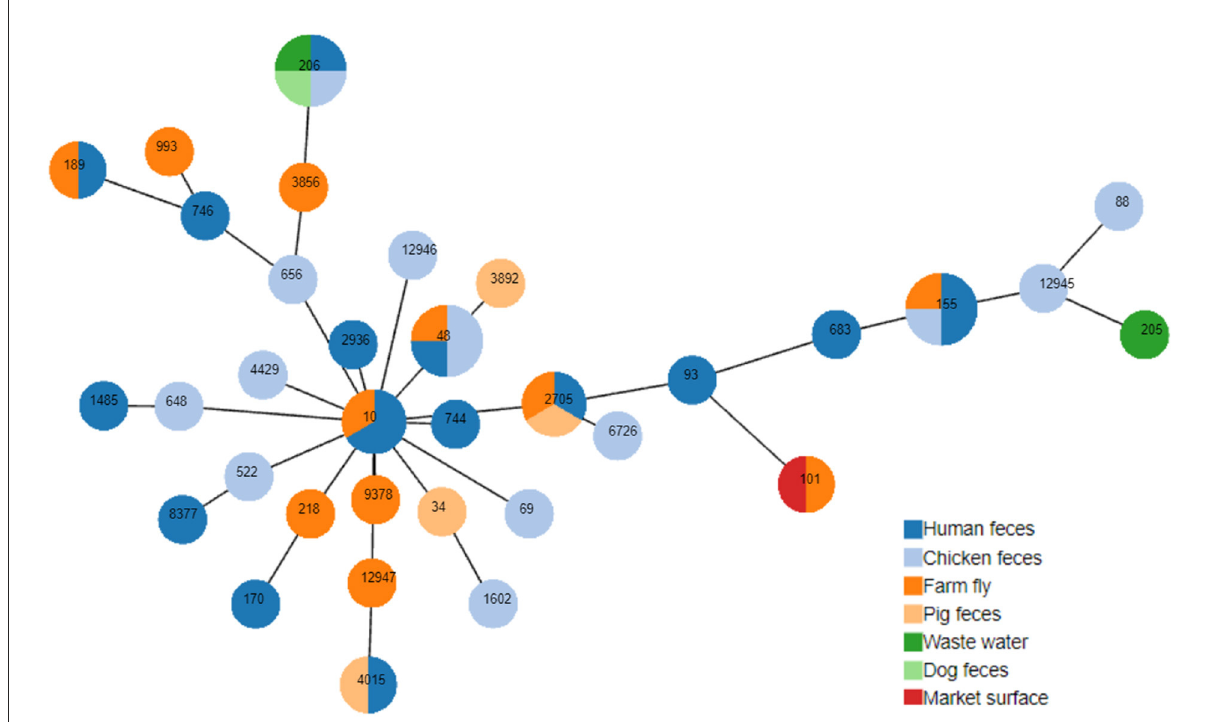
FIGURE1 Minimum spanning tree based on multi-locus sequence types and seven housekeeping gene alleles of MCRPEC. Each circle corresponds to an individual sequence type (ST), the circle size indicated the number of isolates assigned to the same ST; The color of the circle denotes the sample type. The length of the branch is equal to the number of different alleles (calculated using seven MLST genes) between two linked nodes/STs.